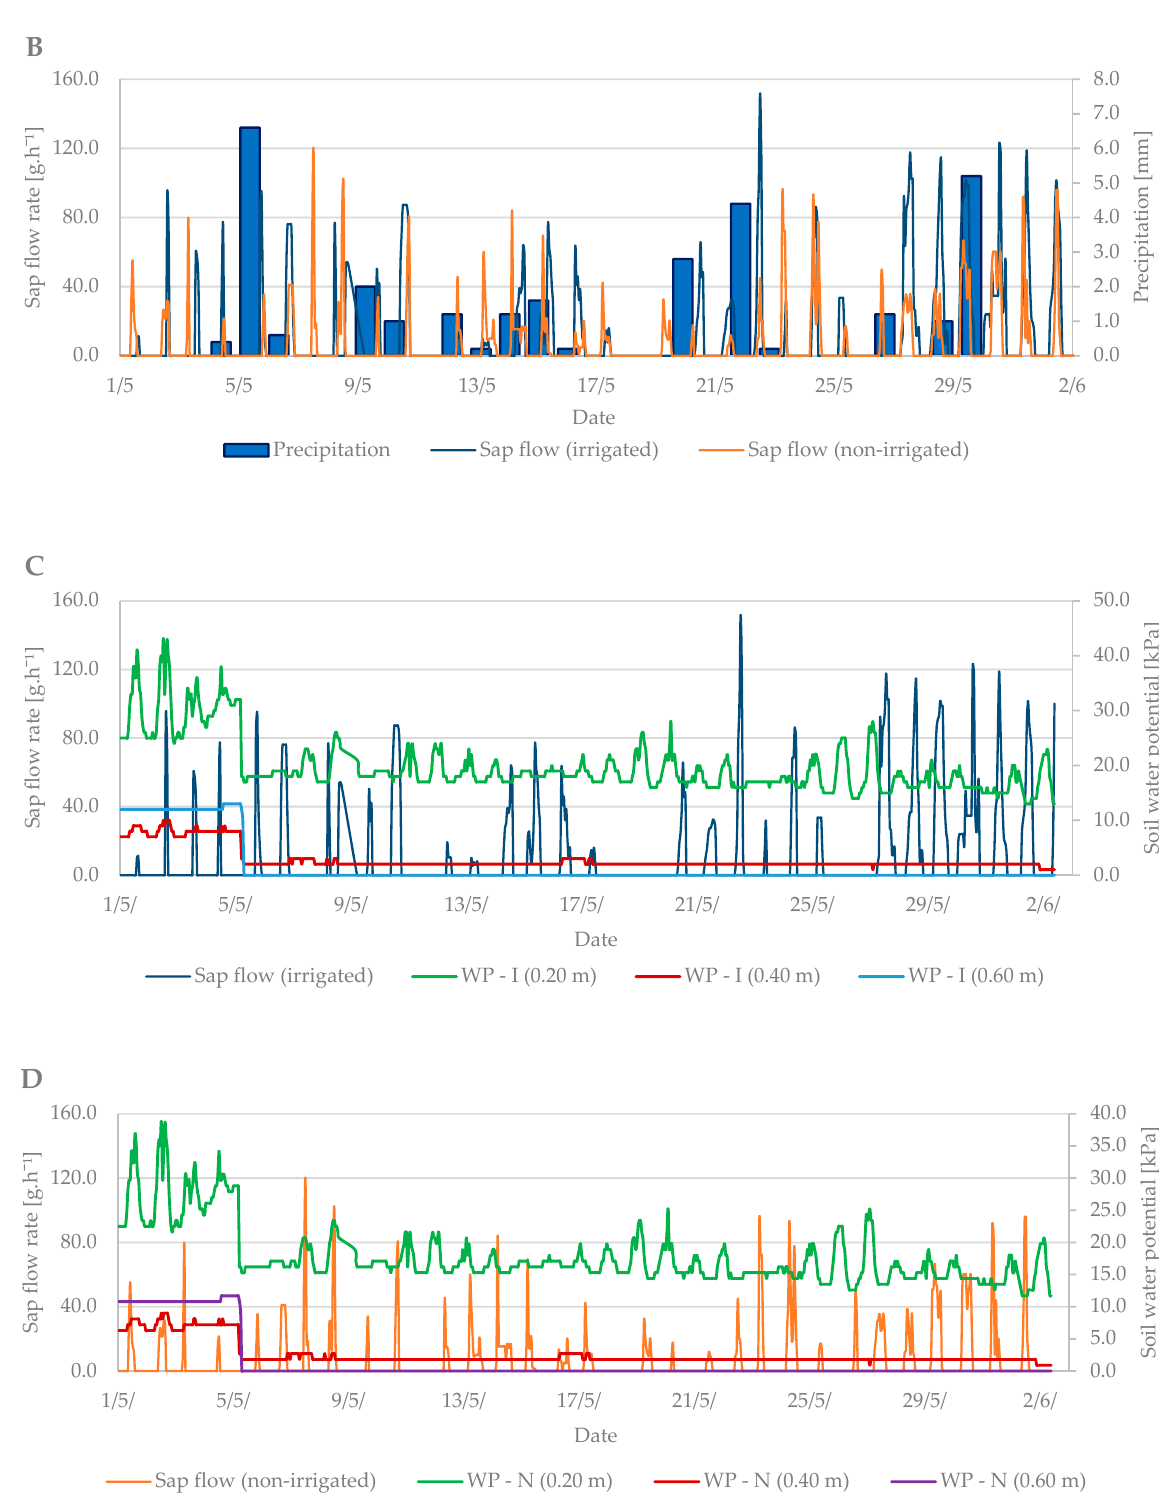
Figure 6. Diurnal course of sap flow rate during the flowering period in 2019 in the irrigated and non-irrigated treatment depending on ( A ) air temperature; ( B ) amount of natural precipitation; ( C ) soil water potential values in the irrigated variant (WP − I) measured in the depth of 0.20, 0.40, and 0.60 m; and ( D ) soil water potential values in the non-irrigated variant (WP − N) measured in the depth of 0.20, 0.40, and 0.60